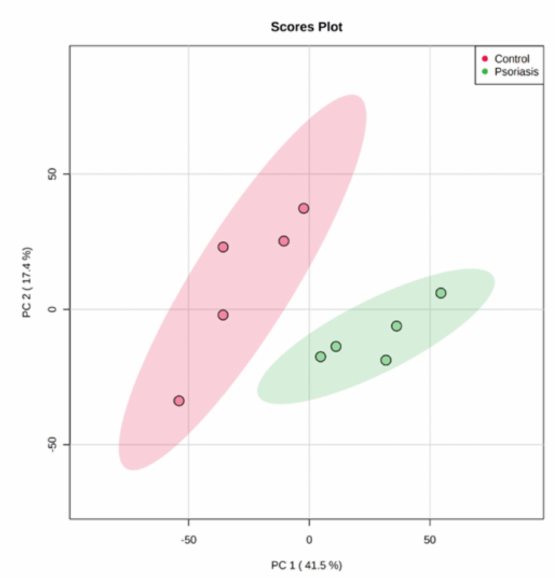
Figure 2. Principal component analysis (PCA) of the proteins in fibroblasts isolated from skin of psoriatic patients ( n = 5) and healthy controls ( n =